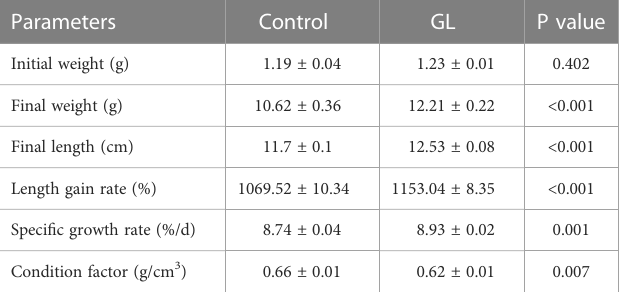
TABLE 6 The effects of b -1,3-glucan on the growth performance of Litopenaeus vannamei .